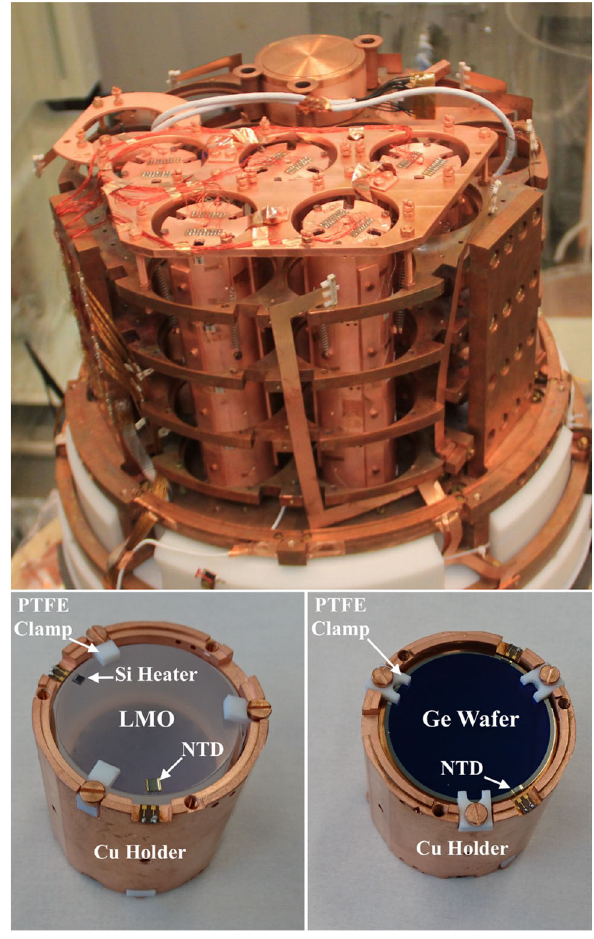
Fig. 1 Images showing the CUPID-Mo detector array (5 nearest tow- ers) mounted in the EDELWEISS cryostat (top) and a single module assembled in the Cu holder (bottom) [41]. (Bottom left) View from the top on the LMO detector, NTD-Ge, Si heater, copper holder and PTFE clamps. (Bottom right) View from the bottom on the Ge LD and its NTD-Ge thermistor and PTFE clamps